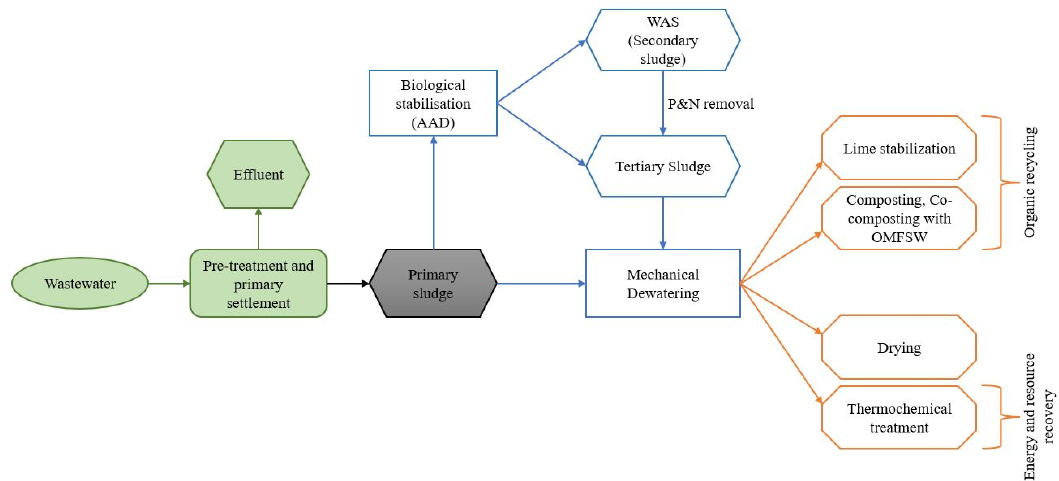
Figure 1. Sewage sludge treatment processes (AAD—Anaerobic digestion, WAS—Waste-activated sludge, OFMSW—Organic fraction of municipal solid waste) [9,14,15]